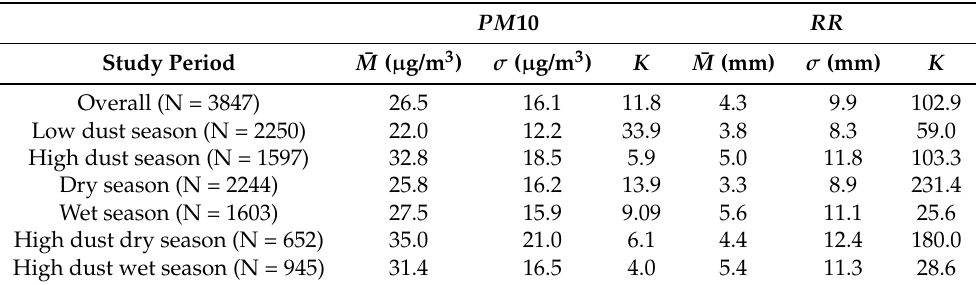
The arithmetic mean ( ¯ M ), standard deviation ( σ ) and Kurtosis ( K ) of PM 10 and RR over 11 years, for low (October to April) and high (May to September) dust seasons, for dry (December to June) and wet (July to November) seasons, and for high dust dry (May to June) and high dust wet (July to September) seasons. N is the sample